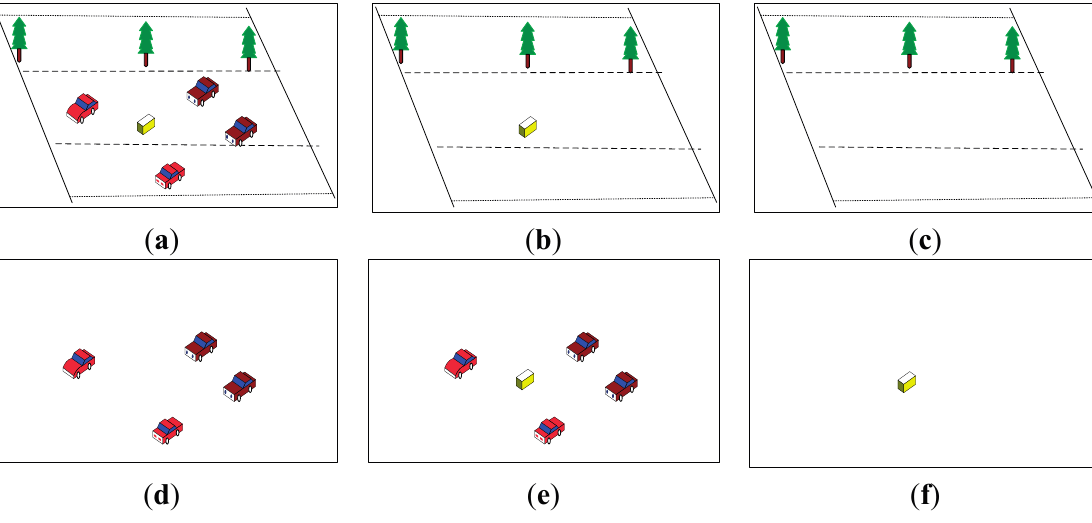
Figure 6. Detection method based on double background models. ( a ) Current image; ( b ) Short-term background image; ( c ) Long-term background image; ( d ) Short-term foreground image; ( e ) Long-term foreground image; and ( f ) Abandoned object.